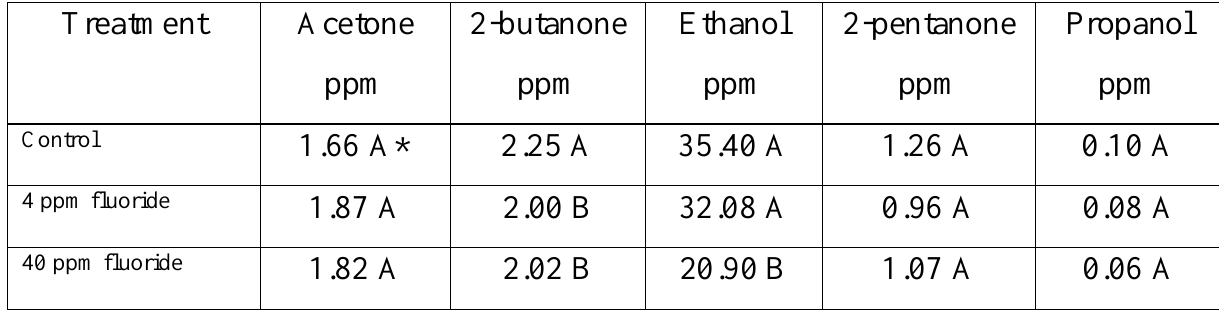
Table (6): Effect of fluoride on organic volatiles of Cheddar cheese at 120 days of ripening Treatment Acetone 2-butanone Ethanol 2-pentanone Propanol ppm ppm ppm ppm ppm Control 1.66 A* 2.25 A 35.40 A 1.26 A 0.10 A 4 ppm fluoride 1.87 A 40 ppm